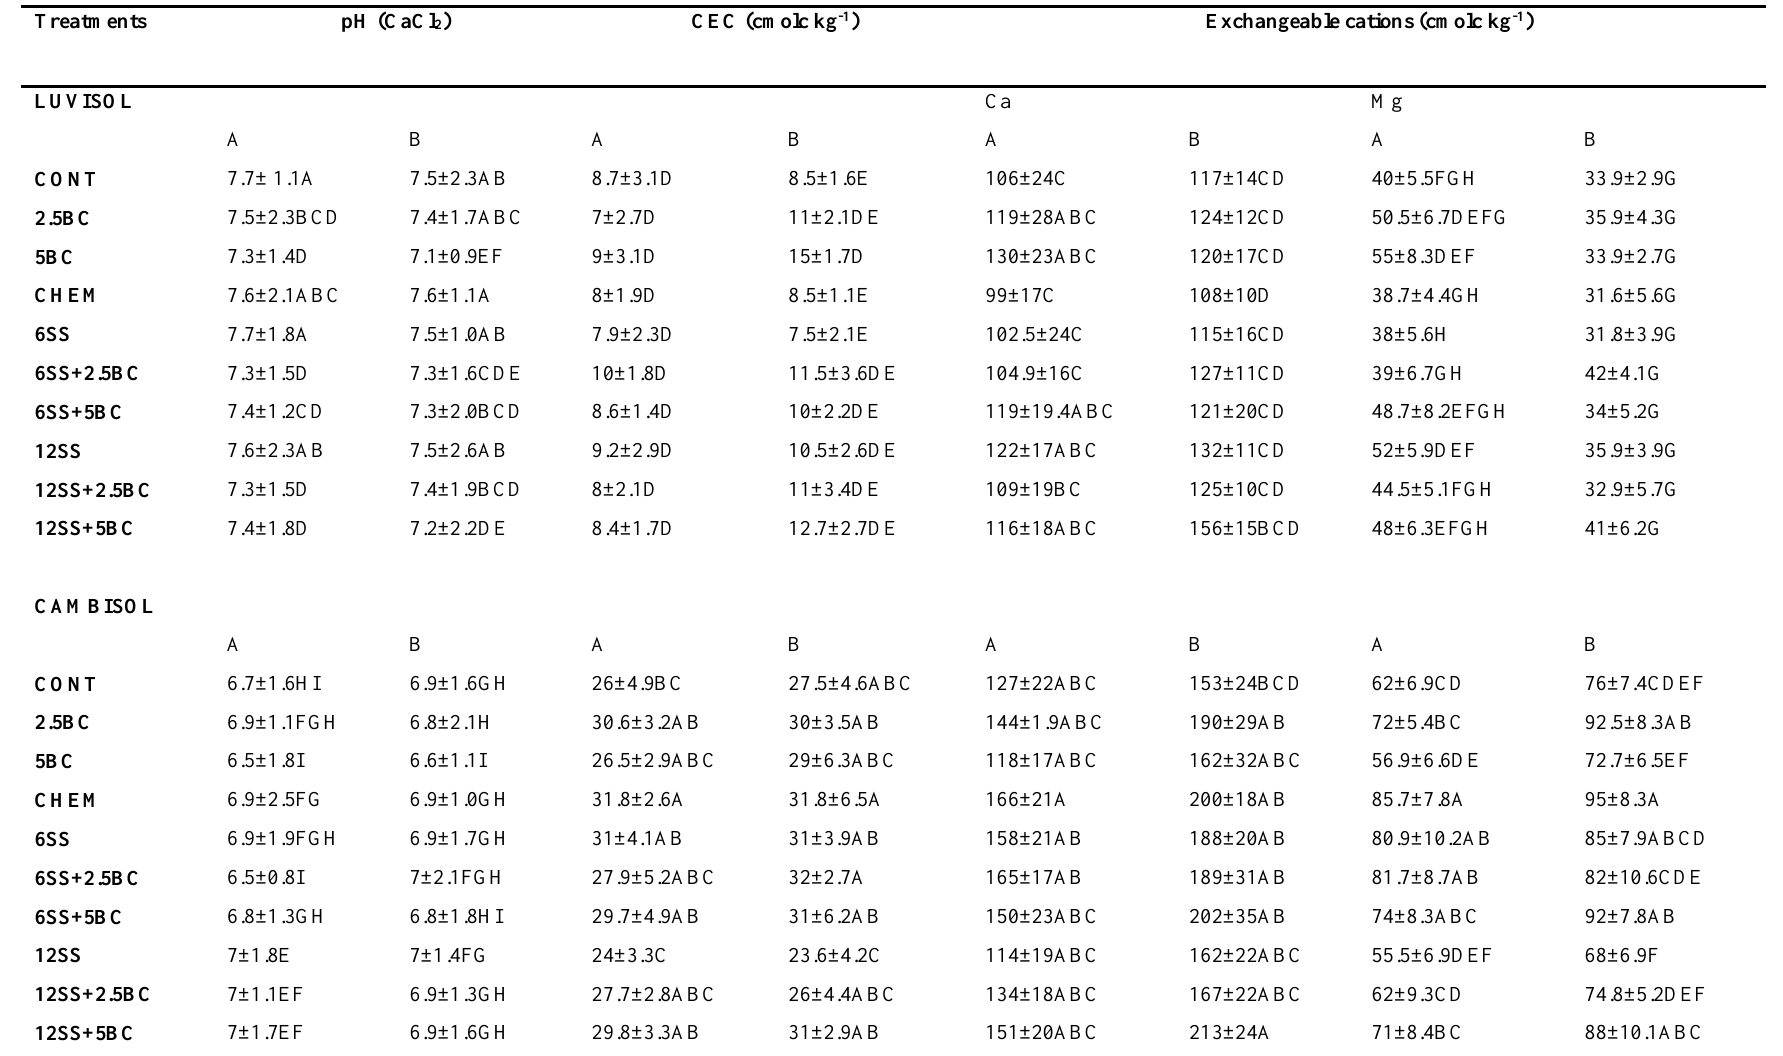
Table 1 Selected soil chemical properties of the sites after Season 1 (A) and Season 2 (B) Treatments